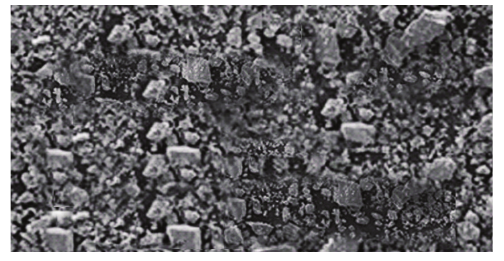
Figure 1: SEM image of steel wool at 500x magnification.